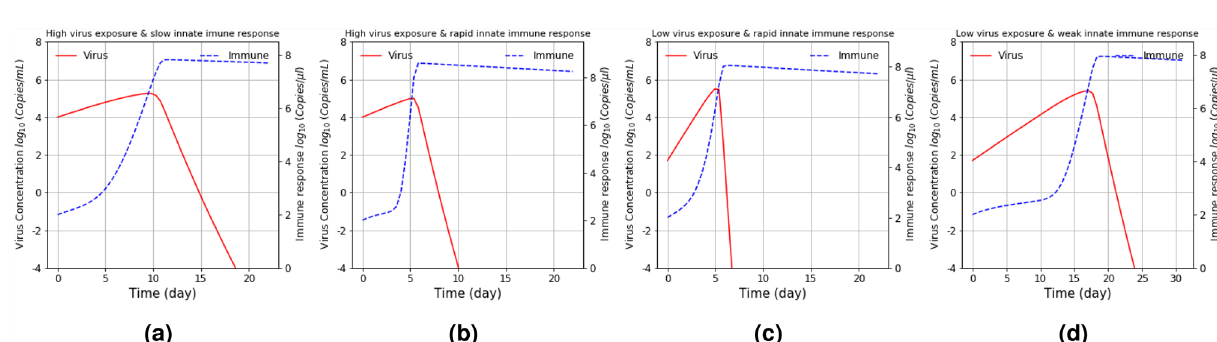
Figure 5. Virus load over the respiratory airways for 21 days with respect to the changes in three different 30 lmin −1 ), (b) density of ACE2 expressed cells ( Q 0 parameters; (a) Infected cell clearance rate d ( Q 0 = 4.71 day − 1 ), and (c) inlet airflow rate Q 0 ( d 4.71 day − 1 ); where the virus concentration lmin −1 and d = = is computed while varying the virus particle diameter d p over the range 70–140 µ m and fixed initial virus 10 7 Copies/ml. concentration C 0 =